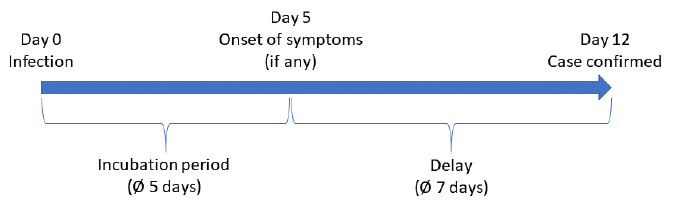
Figure 2: Time between infection and reporting of case